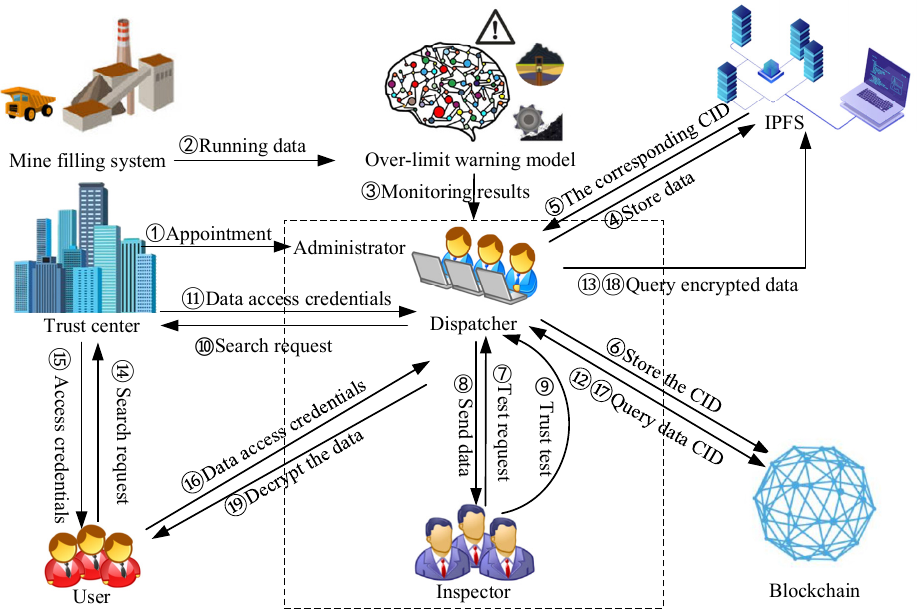
Figure 3. Data management model architecture based on blockchain.